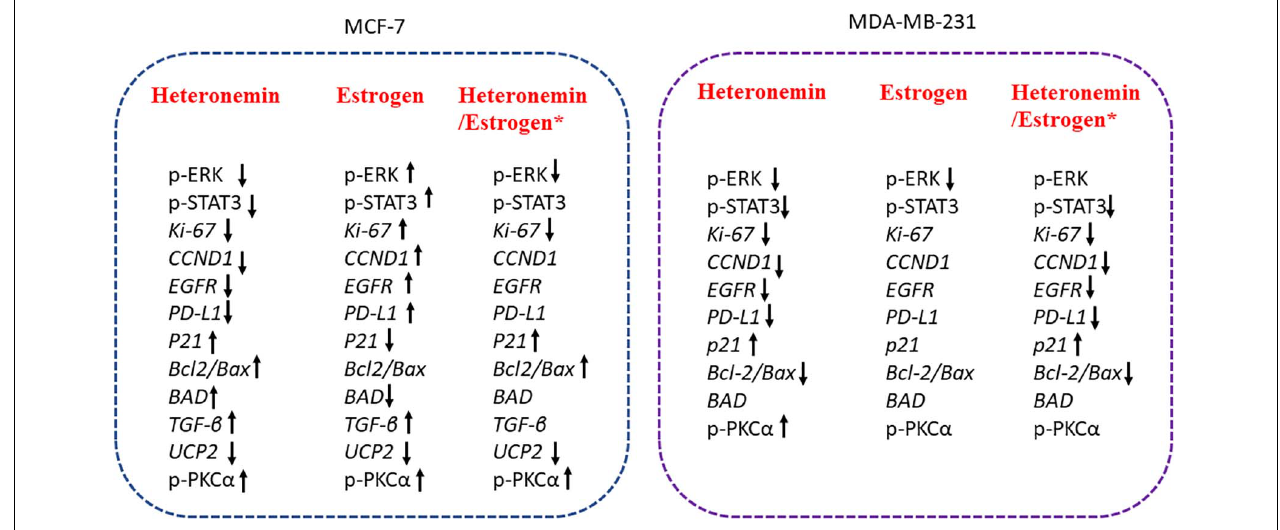
FIGURE 7 | The schematic of heteronemin reverses E 2 –induced mechanism in breast cancer cells. *Significantly different compare with the untreated control group. Heteronemin: 0.625 µ M, E 2 : 1nM.